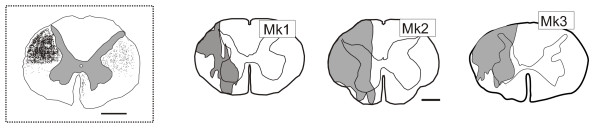
Location and extent of unilateral cervical lesion in Mks 1–3. Location and extent of the unilateral lesion (grey area), performed at C7/C8 level in Mk1, Mk2 and Mk3, shown on a reconstructed frontal view of cervical cord (three rightmost panels). The inset on the left is a frontal section of the macaque monkey cervical cord showing the distribution of CS axons (black dots) as a result of injection of the anterograde tracer Biotinylated Dextran Amine (BDA) in the right motor cortex (as recently reported in [41]). The CS axons originating from the right hemisphere are distributed mainly in the left dorsolateral funiculus (90–95%), representing the decussated CS tract. The uncrossed CS tract (5–10%) comprises, on the right side, axons in the dorsolateral funiculus and in the ventral funiculus. Scale bars = 2 mm.